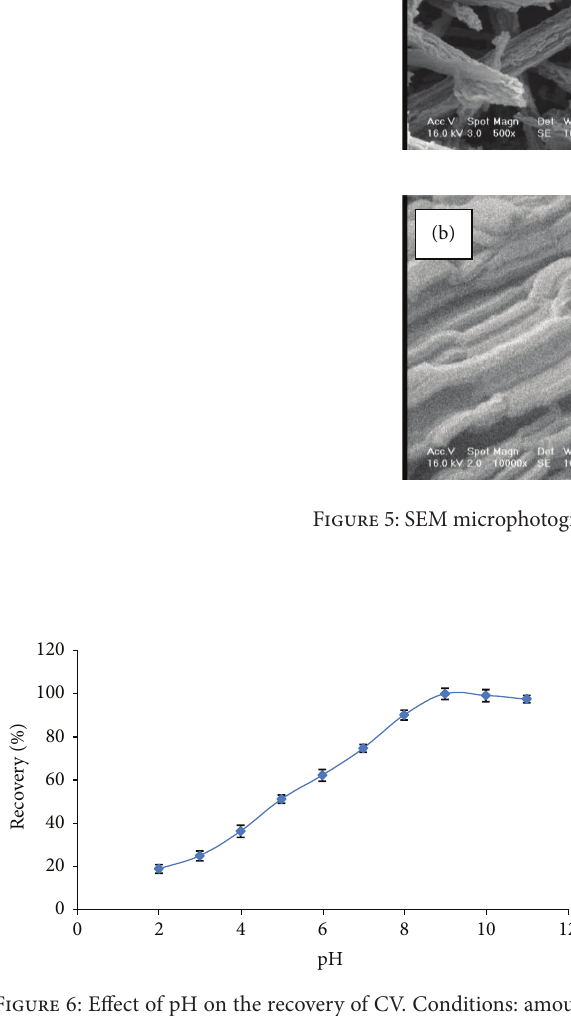
Figure 6: Effect of pH on the recovery of CV. Conditions: amount of CV: 50 𝜇 g L −1 , sample volumes 25mL, amount of sorbent: 15 mg, eluent: glacial acetic acid, and eluent volume: 1.0mL.